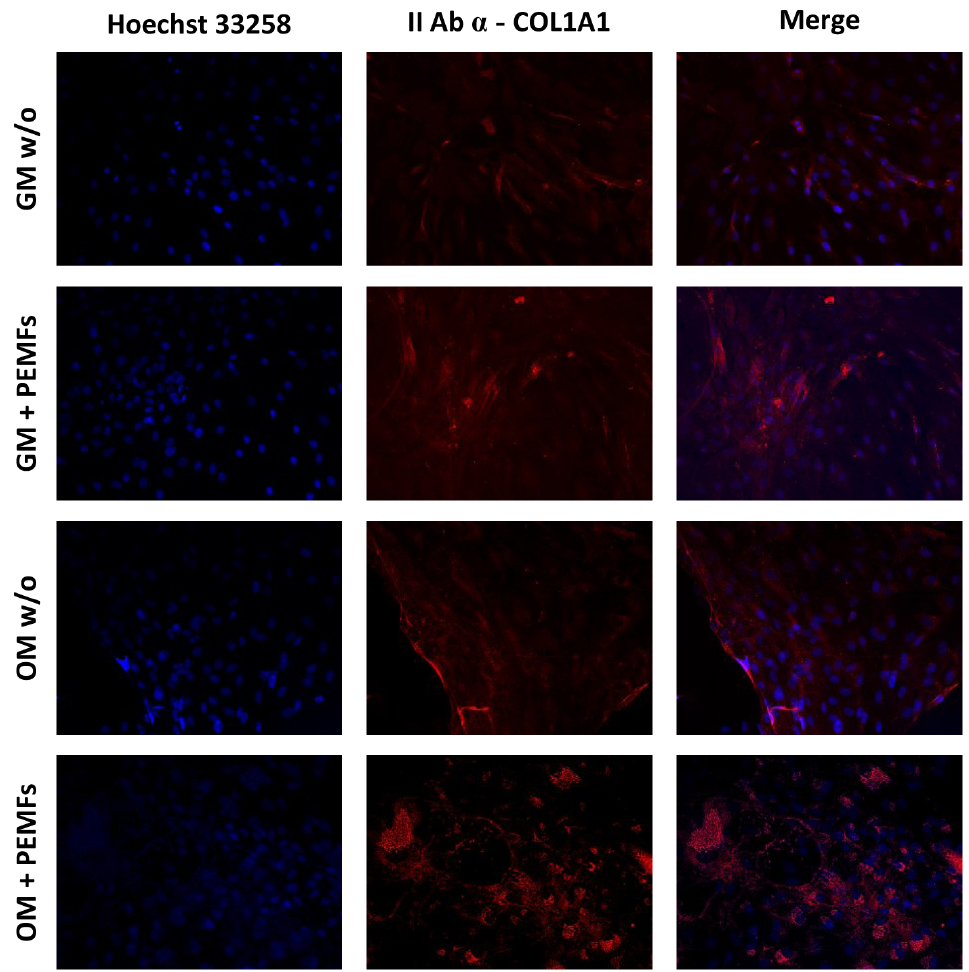
Figure 6. In this panel are reported the IF results of COL1A1 staining. The application of PEMFs induced an increase in collagen I synthesis in hASCs cultured in GM and OM, confirming the gene expression data. Specifically, the application of PEMFs in OM cells induced the major synthesis of collagen I, as demonstrated by the bright spots around the cell nucleus (ER synthesis), supporting the synergistic action of PEMFs and osteogenic factors. Scale bar: 50 µ